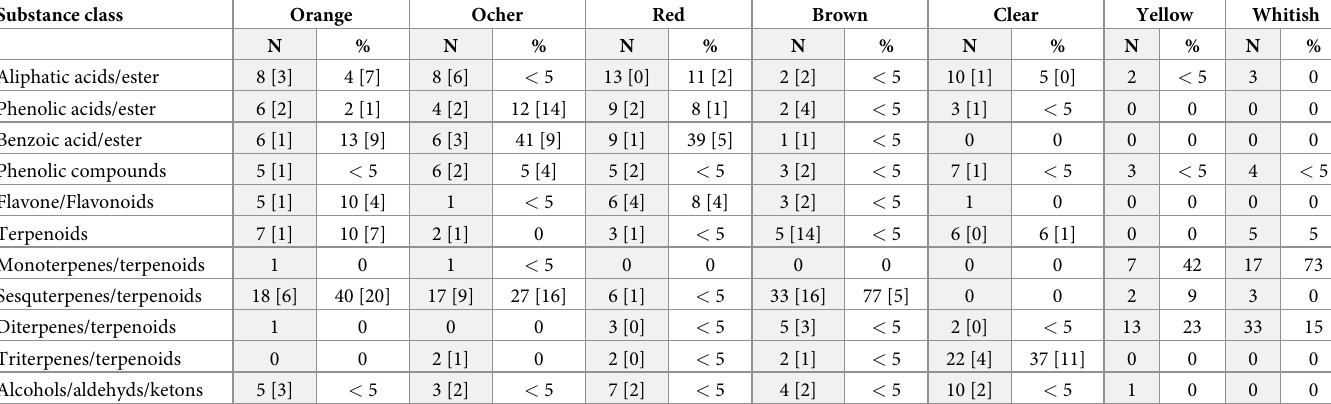
Table 2. Prevalence of specific substance classes in different resin